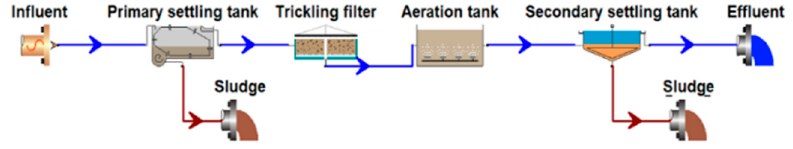
Table 2. The capacity and the required number of WWTPs.